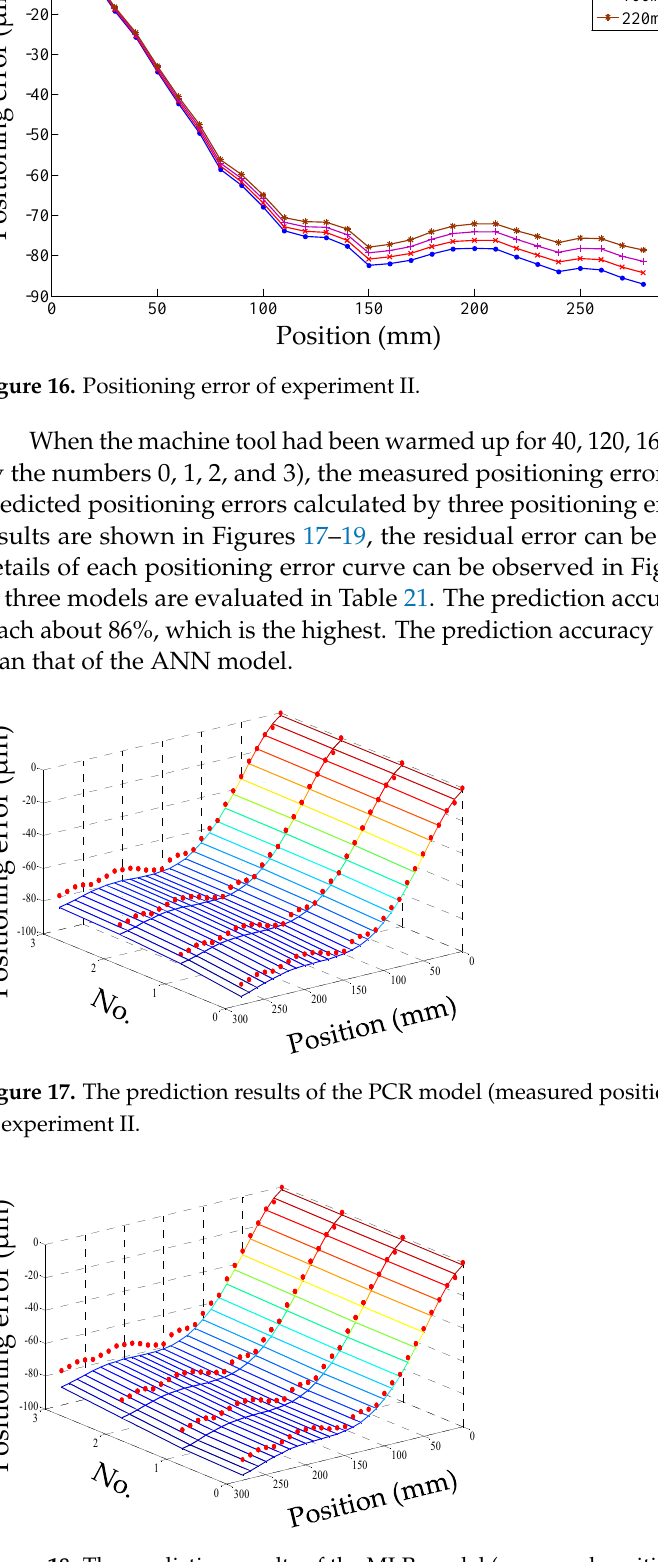
Figure 15. Temperatures of 11 temperature sensors of experiment II.